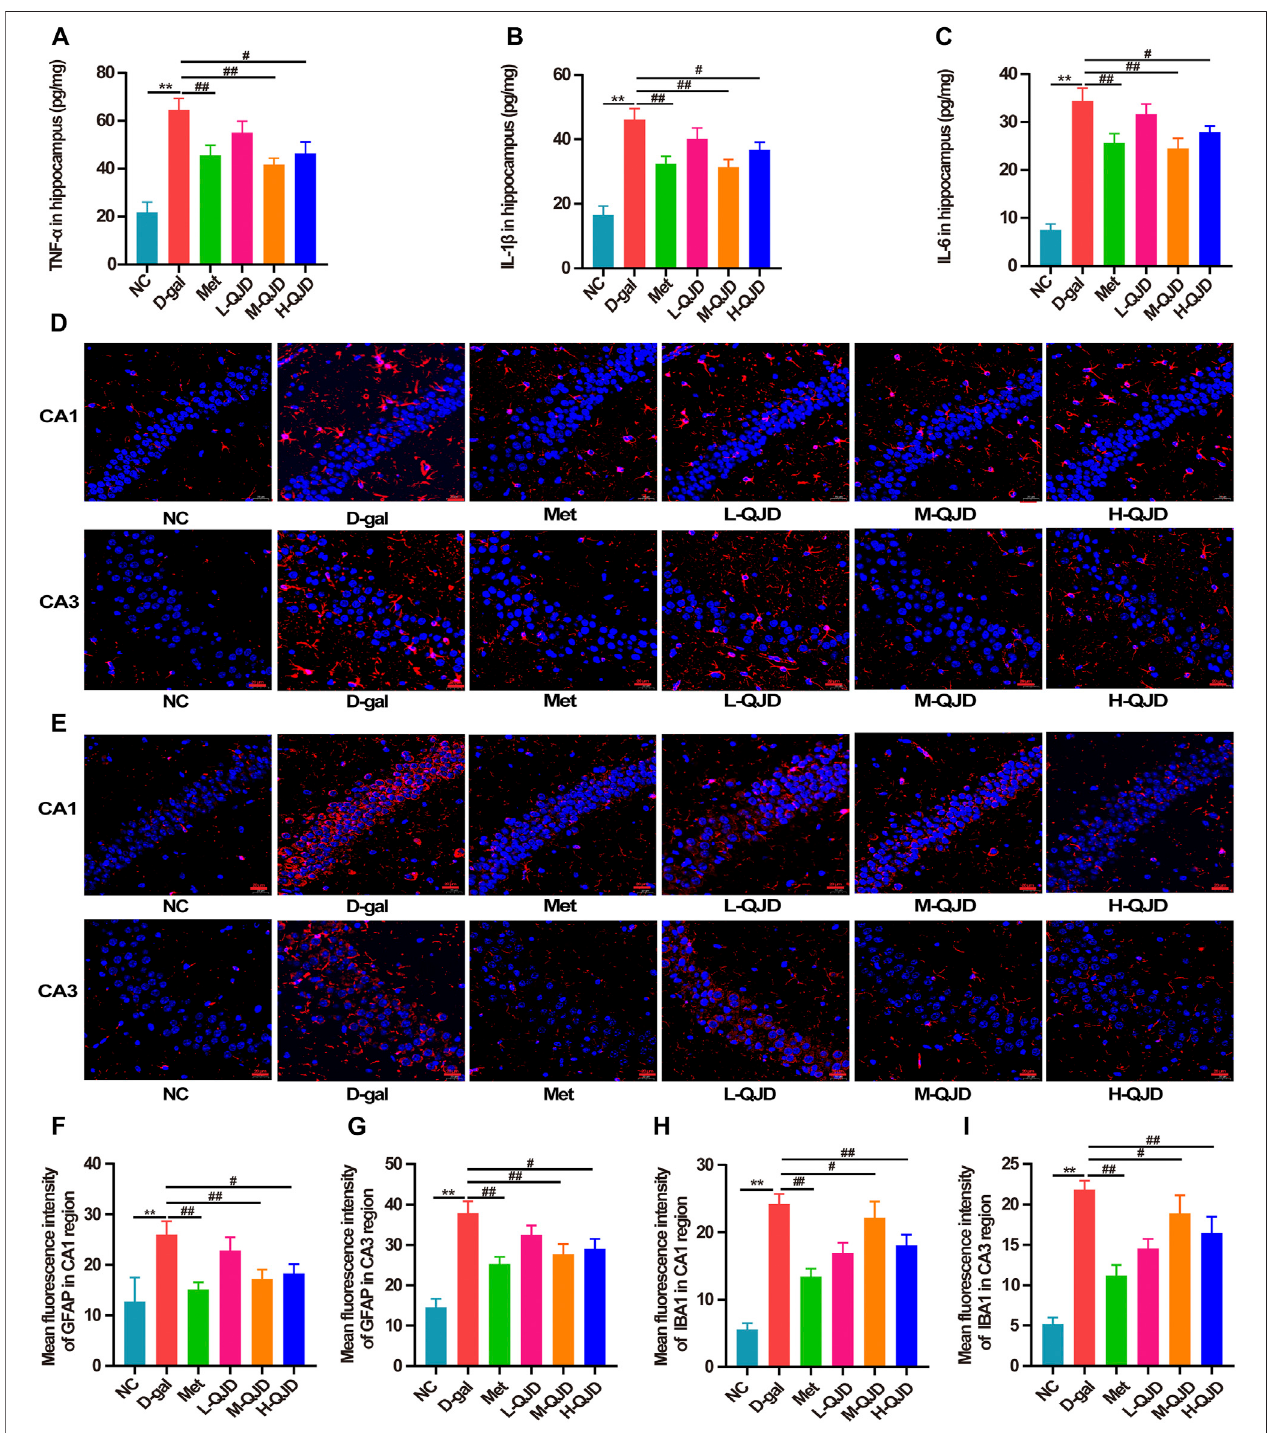
FIGURE4| QJDalleviatedthe neuroin fl ammationthrough suppressing microglialand astrocytic activationinD-gal – induced mice. (A) Proteinexpression ofTNF- α in hippocampus. (B) Protein expression of IL-1 β in hippocampus. (C) Protein expression of IL-6 in hippocampus. (D) Representative immuno fl uorescence staining imagesofGFAP(labeled inred) inthe hippocampus ofCA1 and CA3 regions(magni fi cation × 400;scale bar (cid:1) 20 μ m). (E) Representativeimmuno fl uorescence staining imagesofIBA1(labeledinred)inthehippocampusofCA1andCA3regions(magni fi cation × 400;scalebar (cid:1) 20 μ m). (F) Mean fl uorescenceintensityofGFAPinthe hippocampusofCA1region. (G) Mean fl uorescenceintensityofGFAPinthehippocampusofCA3region. (H) Mean fl uorescenceintensityofIBA1inthehippocampusof CA1 region. (I) Mean fl uorescence intensity of IBA1 in the hippocampus of CA3 region. All data were presented as mean ± SEM ( n (cid:1) 4 or 6/group). ** p < 0.01 vs. NC group; # p < 0.05 and ## p < 0.01 vs. D-gal group.